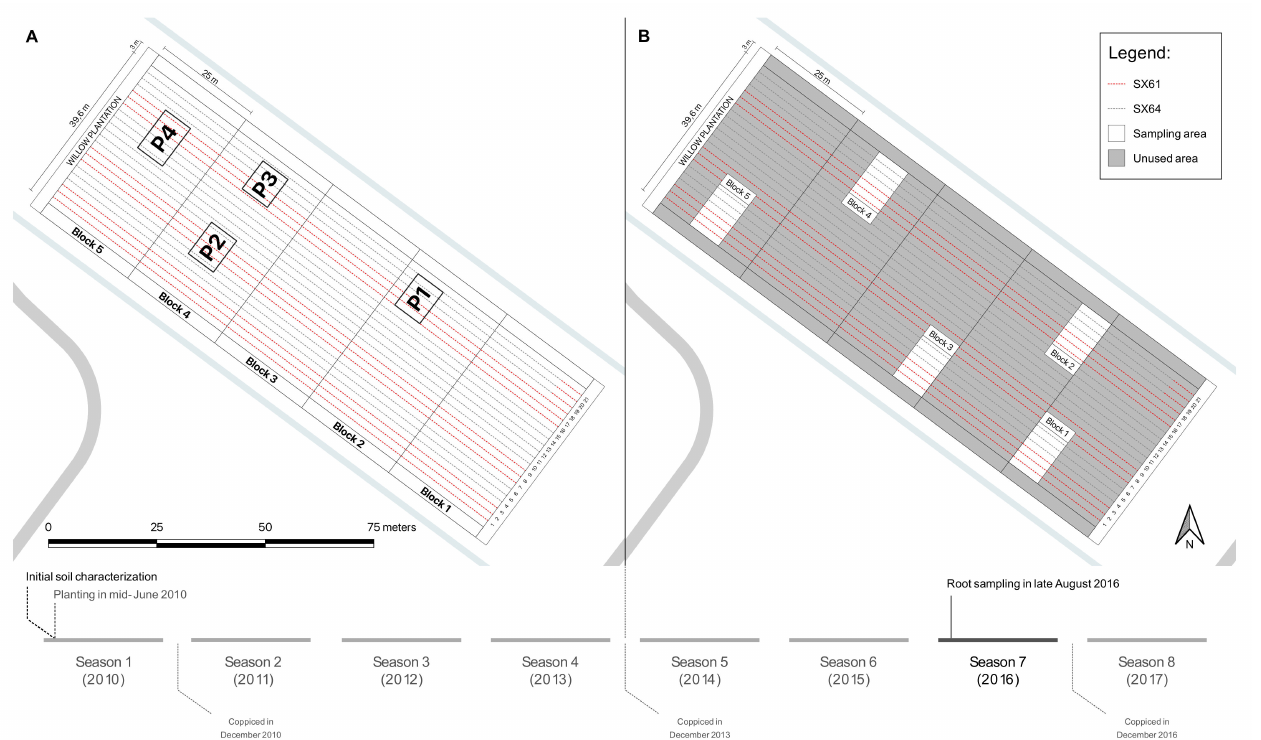
Figure 1. Evolution of the experimental design over time, including growth seasons and coppicing times. The 21 dotted lines inside the willow plantation refer to the rows planted with the cultivar ‘SX61’ (red lines) and with the cultivar ‘SX64’ (grey lines). ( A ) Experimental design of the first experimental phase is referred to as the GERLED site in Guidi et al. [43]. P1, P2, P3, and P4 were the sampling plots in their study; ( B ) Experimental design of the current experiment. White plots refer to the sampling areas. Although preserved as part of the plantation, the sections in dark grey were not used in the present study (Unused area). Adapted from Guidi et al.